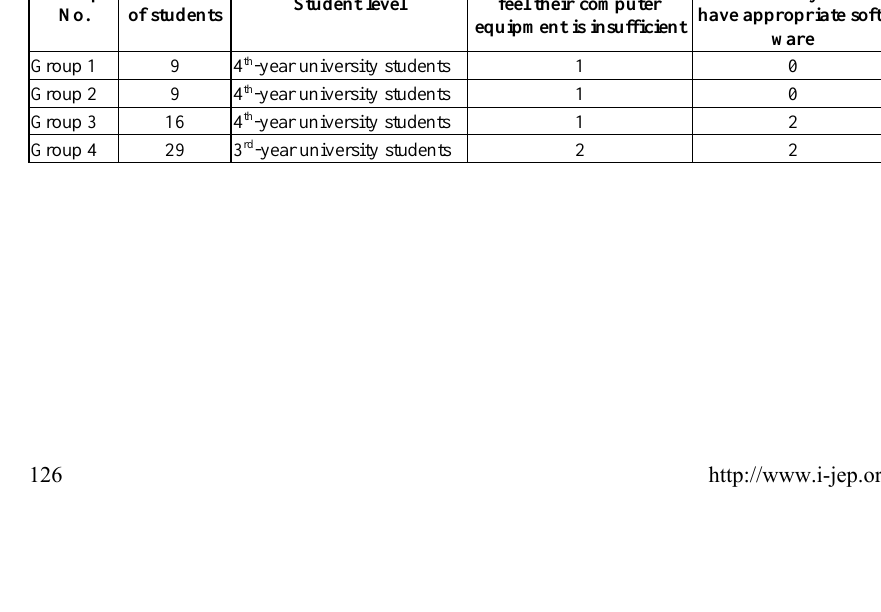
Table 1. Characteristics of the students participating in this study Group